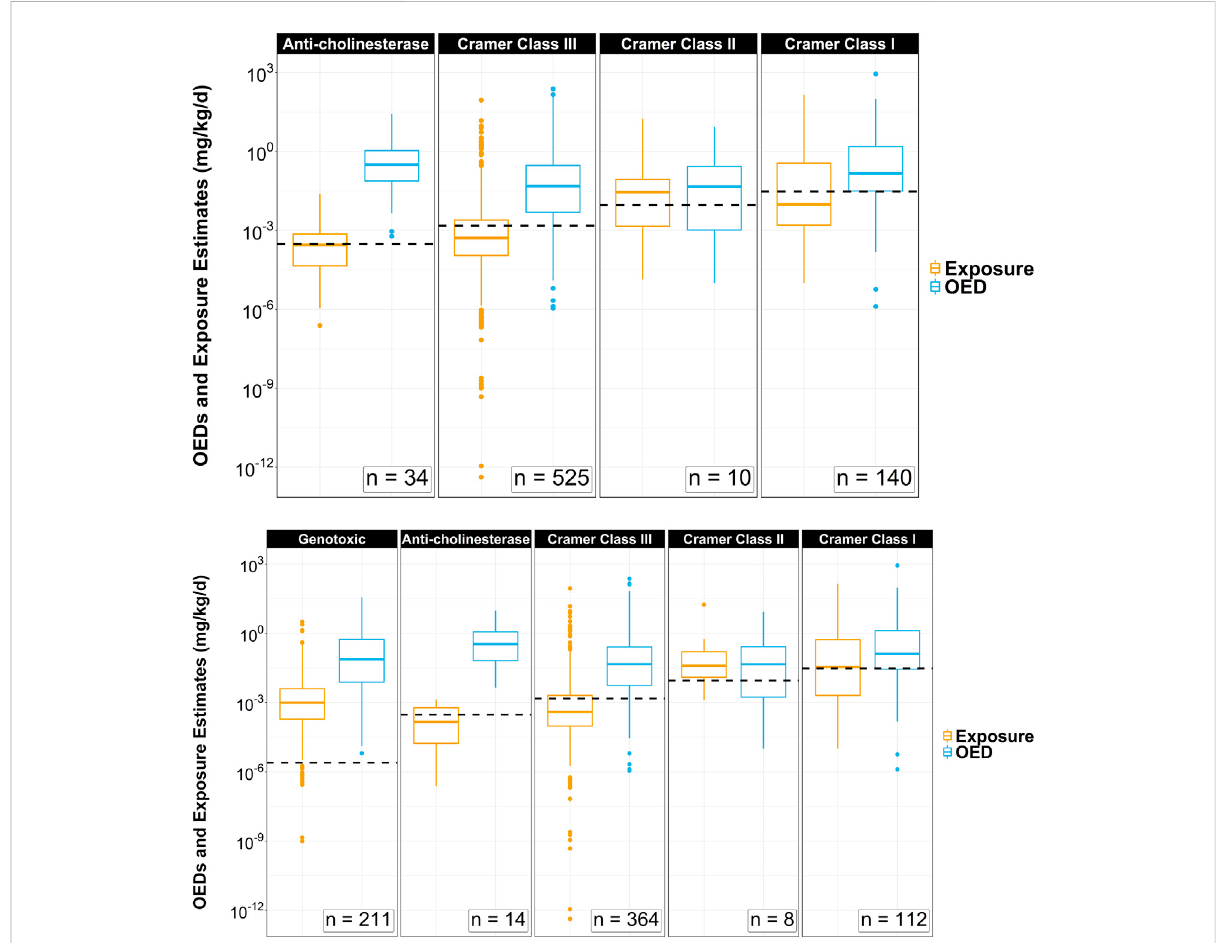
FIGURE 2 Side-by-sideboxandwhiskerscomparisons oforalequivalentdoses(OEDs)andExpoCastSEEMexposuresacrossTTCcategorythresholdsfor 709 ToxCast chemicals that have metabolism data to support HT-IVIVE. The analysis was conducted without (top) and with (bottom) fi ltering for Genotoxicity. Top: The category TTC values represented by the horizontal dotted lines are 0.0025 (bottom only), 0.3, 1.5, 9, and 30 μ g/kg/d. Dots above each box and whisker plot signify chemical outliers for a given range of OED or ExpoCast SEEM exposure estimates in mg/kg-BW/d.